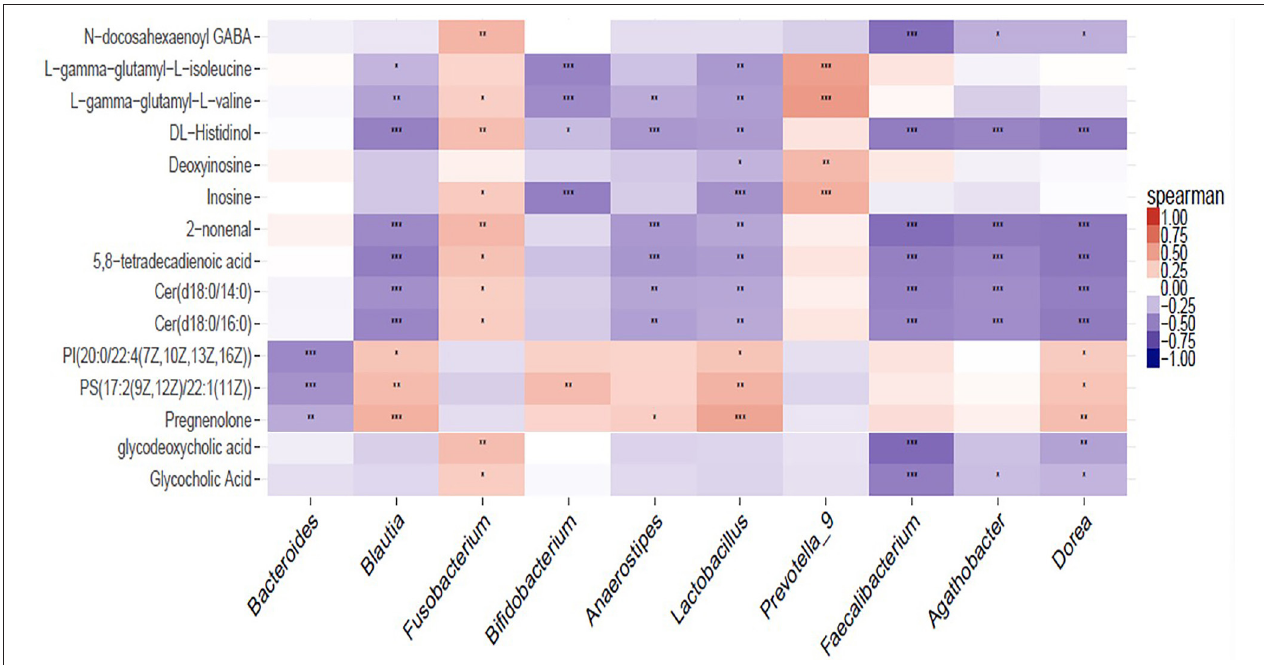
FIGURE 7 | Heat map summarizing the correlation of perturbed gut microbiota genera and altered fecal metabolites. * P < 0.05; ** P < 0.01; *** P <